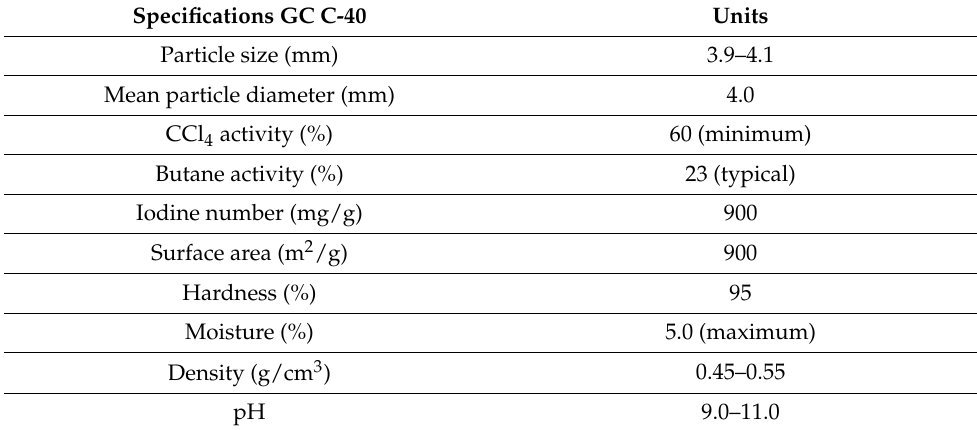
Table 1. Specifications of activated carbon GC C-40.